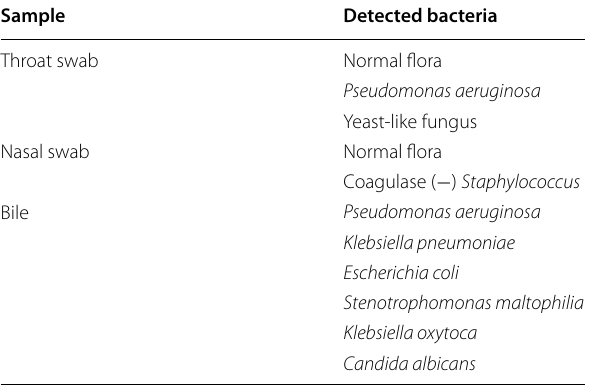
Table 2 Preoperative culture test of case 2 Sample